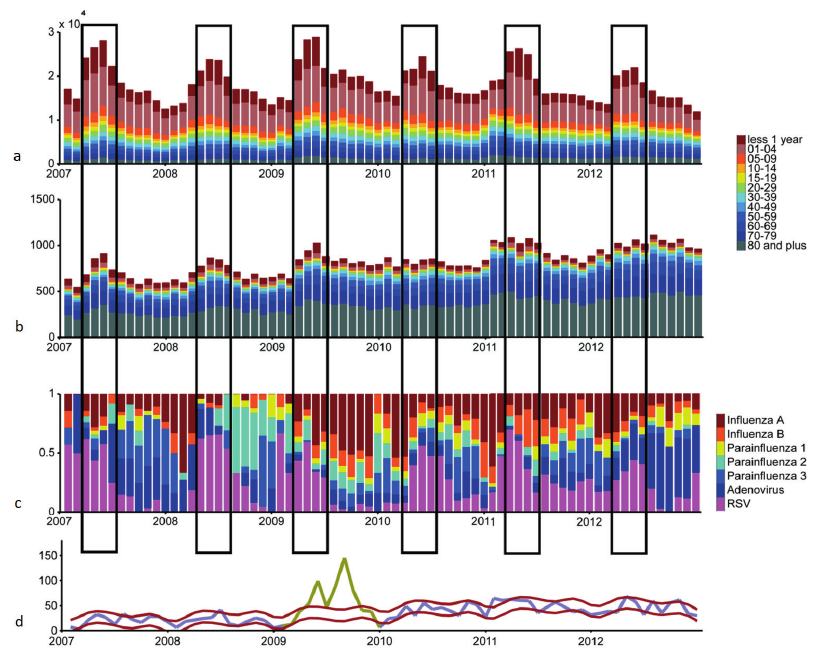
Figure 4. Epidemic monthly series of the “South-Equatorial” zone: ( a ) Hospitalizations in the public sector, ( b ) deaths, ( c ) proportion of respiratory viruses detected ( d ) total respiratory viruses detected and periodic annual function (PAF, when 2009 is